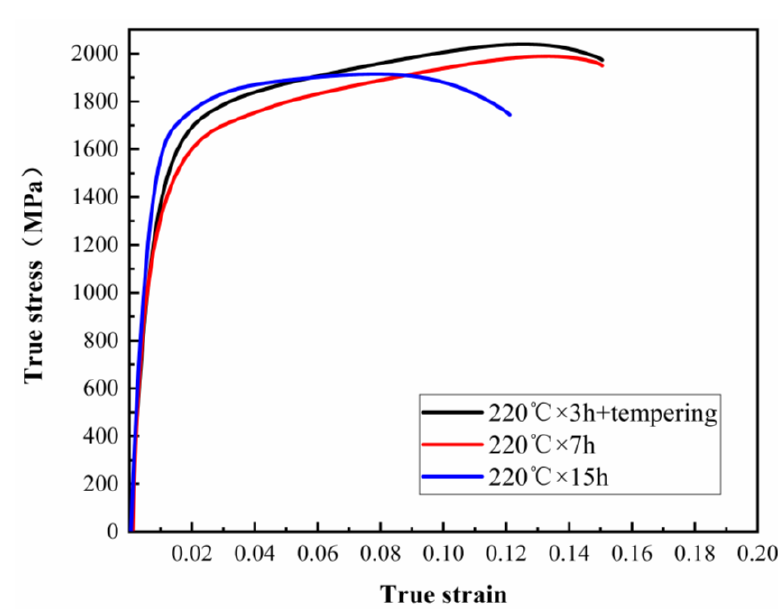
Figure 6. The true stress-strain curves of test steel by different heat treatment processes.